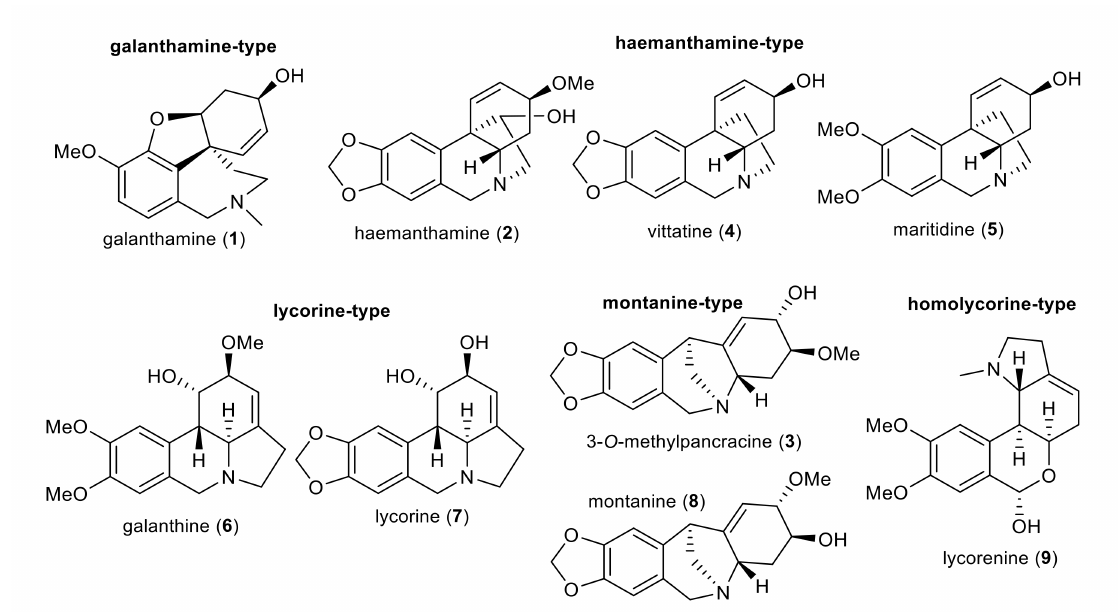
Figure 4. Structures of tested Amaryllidaceae alkaloids of different structural types. Table 1. In vitro antimycobacterial activity against Mtb H37Ra, Mycobacterium aurum and M. smegmatis (MIC), cytotoxicity (IC 50 ), selectivity index (SI) and calculated lipophilicity (logP, ClogP) of Amaryllidaceae alkaloids and their derivatives.